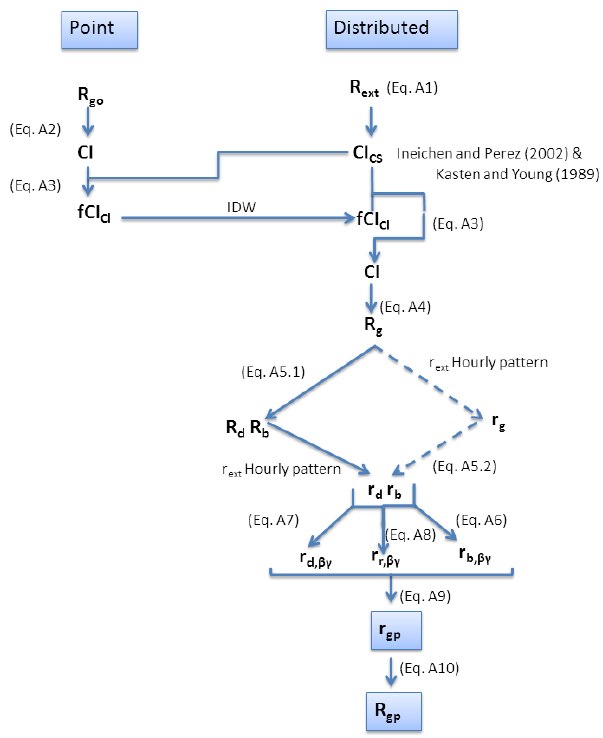
Figure A1. Flowchart of the solar radiation model. Firstly, daily extraterrestrial radiation ( R ext in MJ m − 2 d − 1 ) is computed by integrating the extrater- restrial radiation incident upon a horizontal surface relative to the sun’s beams from sunrise to sunset (Eq.